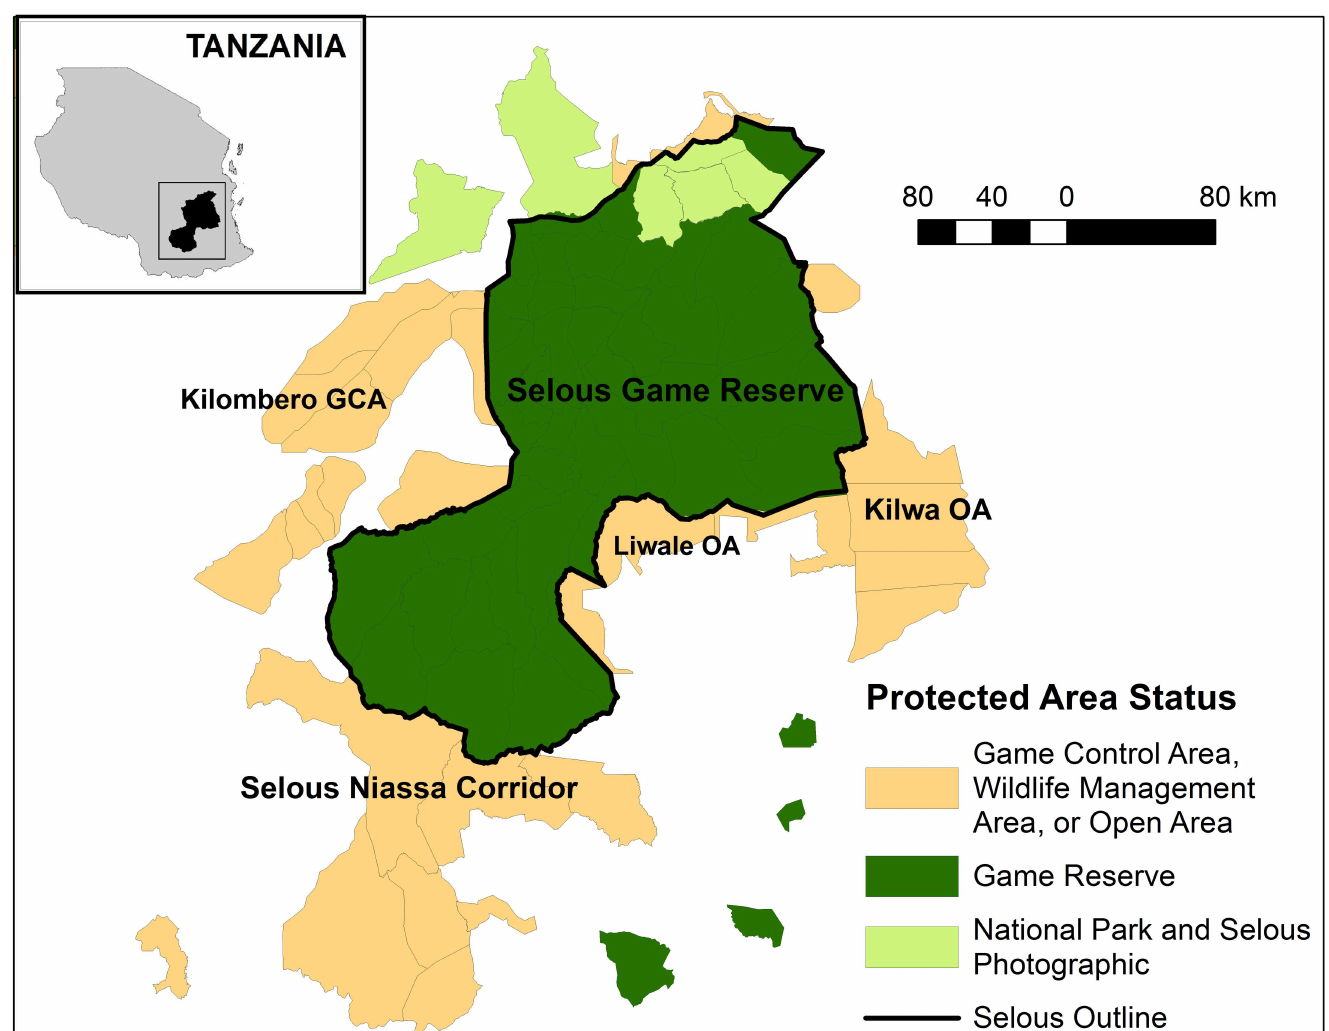
Fig 1. SelousGame Reserveand borderinghuntingblocks and